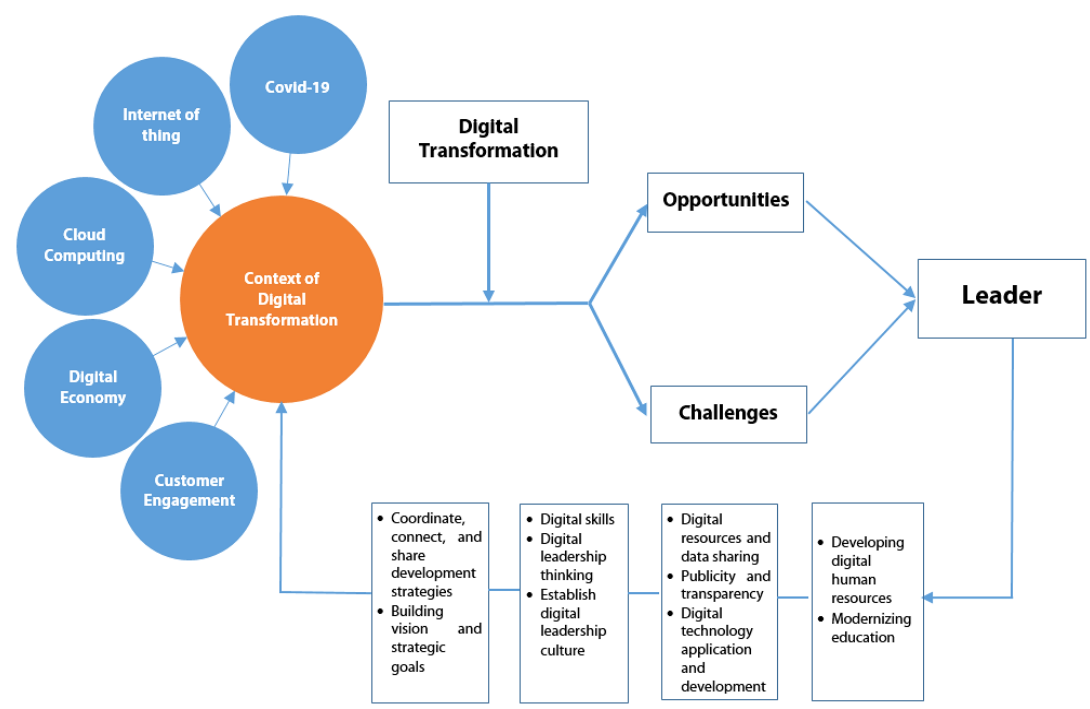
Figure 1. Flowchart of the literature review procedure.